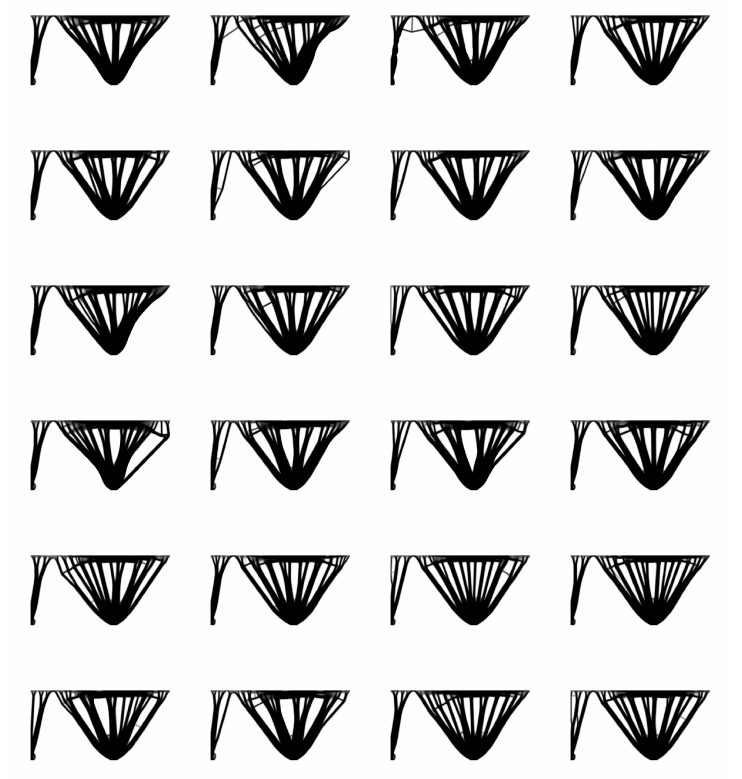
Figure 6. Results for test example